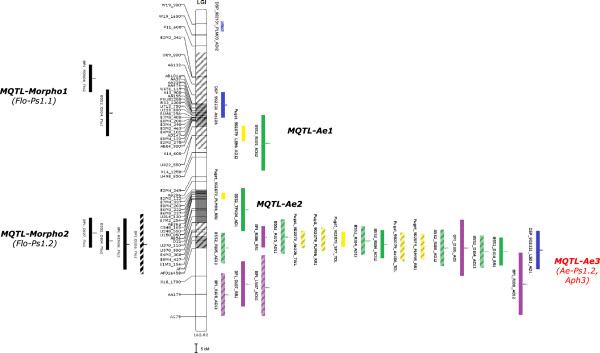
Localization of individual QTL and meta-QTL for resistance and morphological traits onto the consensus marker map: linkage group I. Individual QTL and meta-QTL detected are represented on the right of each linkage group (LG) for resistance to A. euteiches and on the left of each LG for morphological and phenological traits. Marker names are indicated on the left of each LG of the consensus map. Genetic distances between markers are represented in cM Kosambi, according to Additional file 10. Each LG size is indicated in cM Kosambi at the bottom of the LG. LOD-1 confidence interval of initial QTL detected for resistance to A. euteiches from Puget x 90–2079, DSP x 90–2131, Baccara x PI180693 and Baccara x 552 RIL populations are indicated by yellow, blue, purple and green boxes, respectively. LOD-1 confidence interval of initial QTL detected for earliness and plant height are indicated by black bars. Names of initial QTL are coded according to RIL population, field environment and year, A. euteiches isolate and scoring criterion, as mentioned in Additional file 5 of this study and in Hamon et al.[46]. Redundant initial QTL which were not considered in the meta-analysis are indicated in hatched boxes. Main genomic regions comprising overlapping individual QTL are named “Ae-Ps” or “Aph” for resistance to A. euteiches according to [46] and [45], respectively, and “Flo-Ps” or “HT-Ps” for earliness and plant height, respectively. Meta-QTL are named “MQTL-Ae” and “MQTL-Morpho” for resistance to A. euteiches and morphological/phenological traits (earliness, plant height), respectively. Meta-QTLs highlighted in red correspond to the 7 main consistent genomic regions identified for resistance to A. euteiches (Table 3). Confidence intervals of meta-QTL are represented by grey and hatched boxes in the width of each LG for resistance to A. euteiches and morphological/phenological traits, respectively.